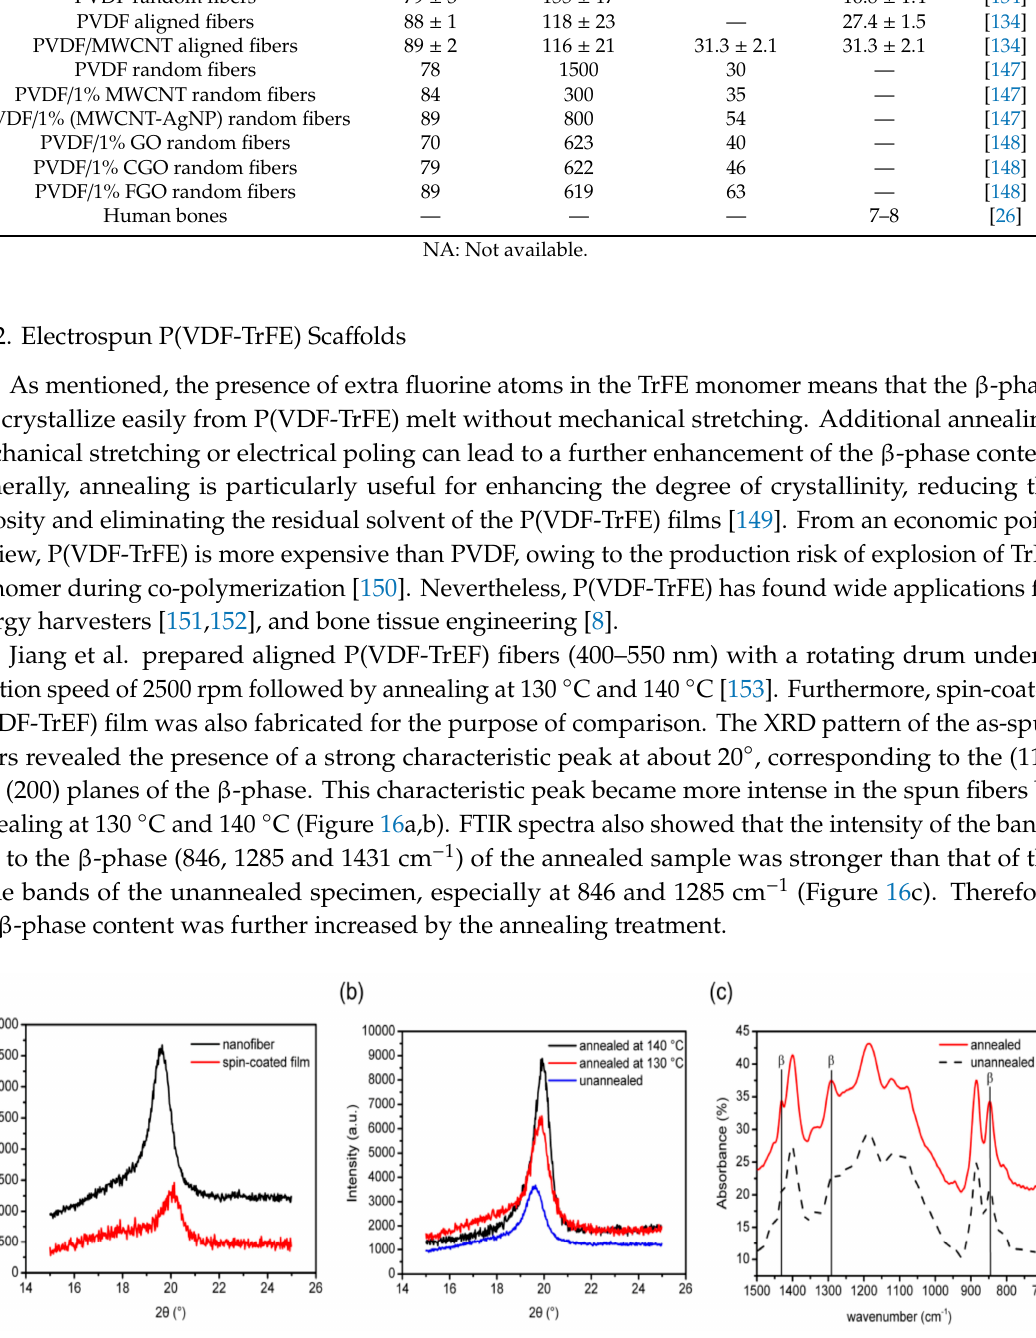
Figure 16. ( a ) X-ray diffraction (XRD) patterns of spin-coated P(VDF-TrFE) film and electrospun P(VDF-TrFE) nanofibers. ( b ) XRD patterns of the P(VDF-TrFE) nanofibers before and after annealing at 130 °C and 140 °C for 2 h. ( c ) FTIR spectra of the P(VDF-TrFE) nanofibers before and after annealing at 140 °C for 2 h.